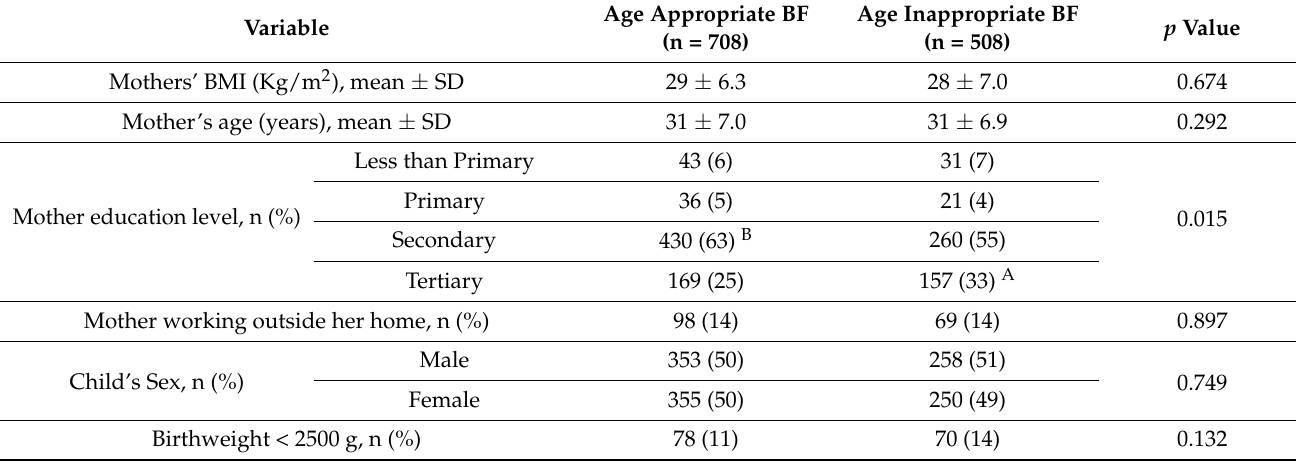
Table 2. Participants’ characteristics by age appropriate BF